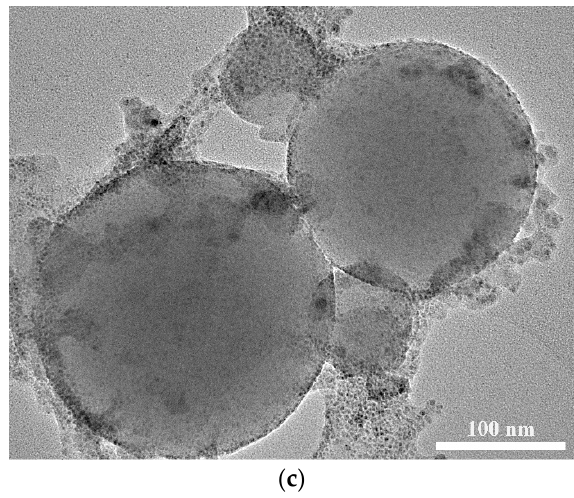
Figure 6. SEM images of SF ( a ); TEM images of GO ( b ) and GOSF ( c ).